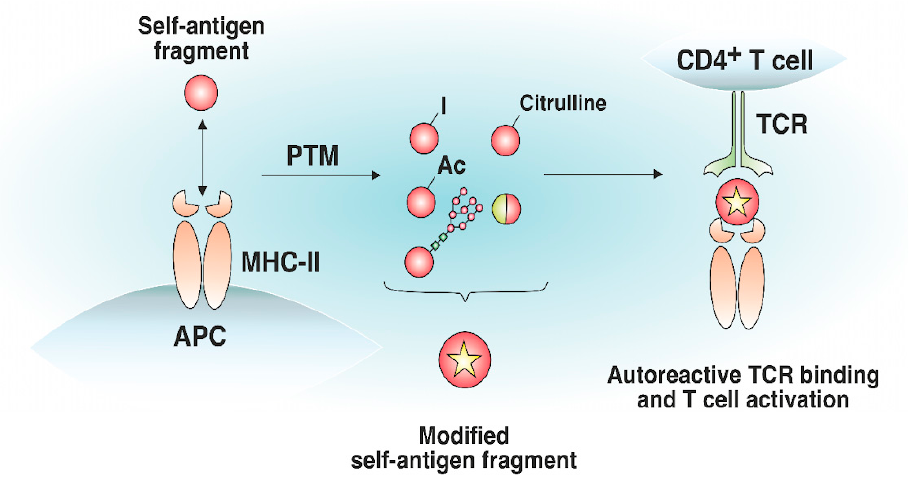
Figure 4. Effect of posttranslational modifications of self-antigens on trimolecular complex assembly. Certain self-antigen fragments do not bind to MHC-II molecules, or their binding affinity is low. Similar self-antigen with posttranslational modifications (iodination, acetylation, glycosylation, citrullination, generation of hybrid peptides, etc.) exhibiting increased affinity for MHC-II molecules, can appear in peripheral tissues. The resulting pMHC complexes can bind autoreactive T cells that have not undergone negative selection in the thymus.